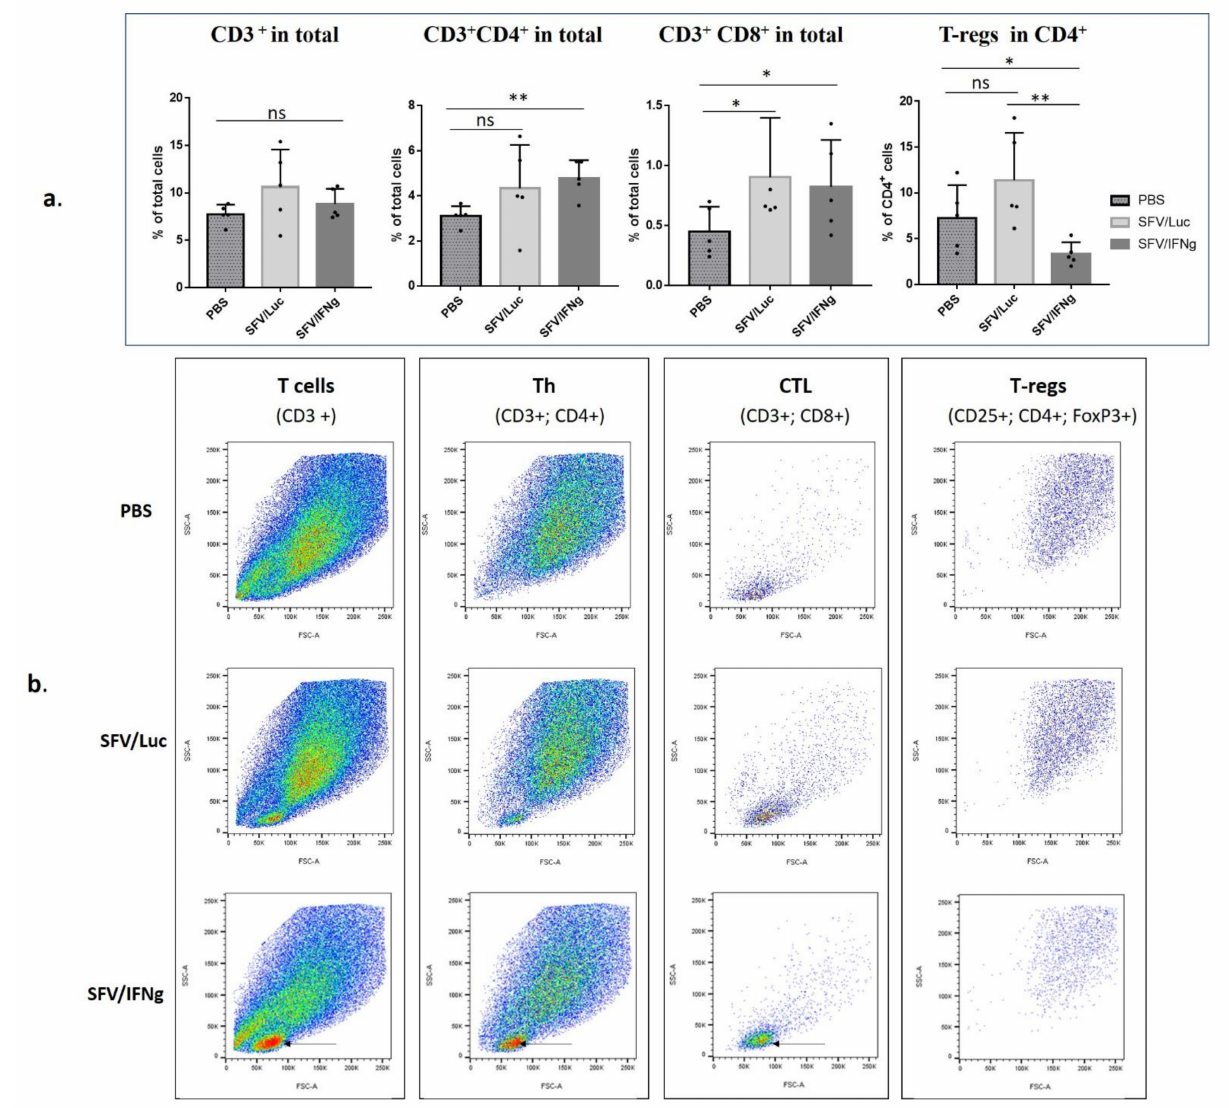
Figure 8. Flow cytometry analysis of T cells in the tumors treated with SFV/IFNg, SFV/Luc, or PBS in orthotopic 4T1 mouse breast cancer model (mice were treated as presented in Figure 6d). Resected tumors were homogenized to obtain a single cell suspension, which was used for immunostaining with antibodies against surface markers (CD3, CD4, CD8, CD25) and intracellular markers (FoxP3) in one mixture. ( a ) Percentages of cell populations. Th cells were identified as CD3 + /CD4 + ; CTL cells as CD3 + /CD8 + , and T-regs as CD4 + /CD25 + /FoxP3 + populations. ( b ) Representative pictures of forward and side (SSC-A/FSC-A) scattering of the cell populations. Arrows indicate the increased population of lymphocytes in the SFV/IFNg group. Bars represent the means ± SD ( n = 5); * p < 0.05; ** p < 0.01;